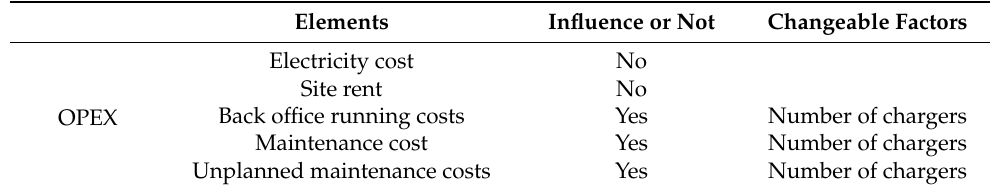
Table 17. Influential factors.